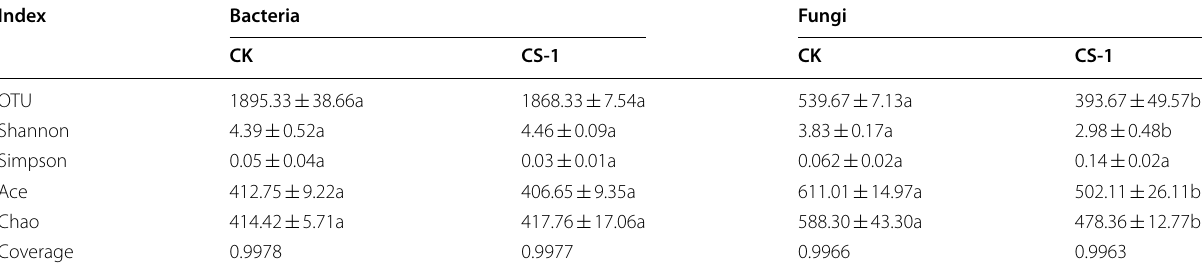
Chao and ACE value are indicators of species richness. Shannon and Simpson are indicators of species diversity. Values are mean common letter within the same column are not significantly different at P <